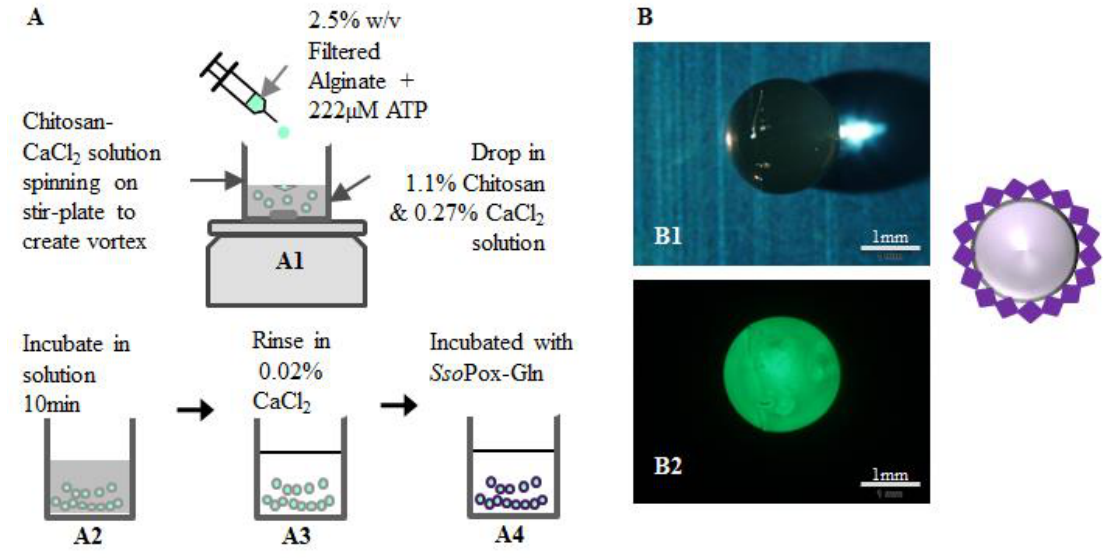
Figure 6 Capsule construction for AI-1 lactonase quenching. As illustrated in ( a ), capsules were constructed by dropping a mixture of 2.5% w / v filtered alginate and 222 µM ATP via 27 G needle into a stirred chitosan-CaCl 2 solution to form capsules (A1) which were then incubated 10 min (A2). The capsules were removed from the incubation media and rinsed in 0.02% w / v CaCl 2 (A3) before binding with Sso Pox (A4) and subsequent QS quenching. Images of the capsules as taken by a stereo-microscope are shown (B1, B2). Here green fluorescently-labeled Sso Pox-Gln is bound to a capsule.